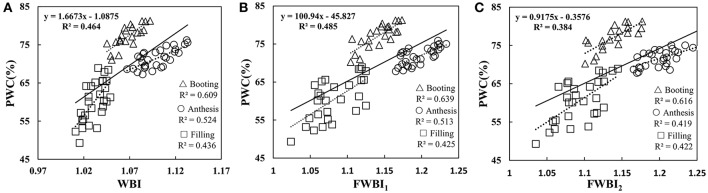
Relationship between (A) WBI, (B) FWBI1, and (C) FWBI2 with PWC. Data points from Experiments 1–3 (n = 82).